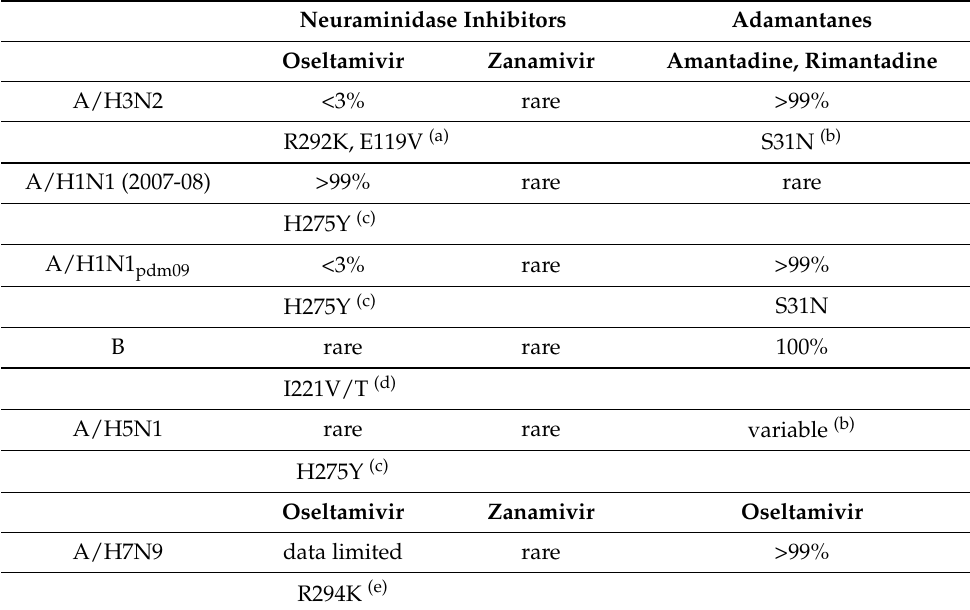
Table 2. Antiviral resistance in human infections caused by seasonal, pandemic and avian influenza viruses. Typical mutations associated with clinical resistance are